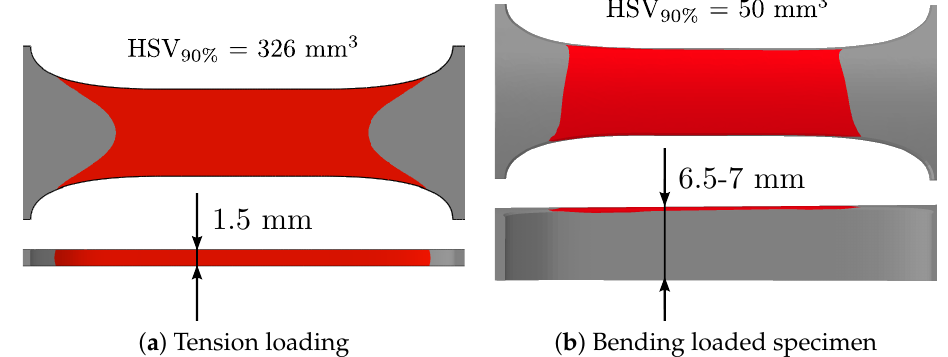
Figure 6. Highly stressed volume of investigated samples.